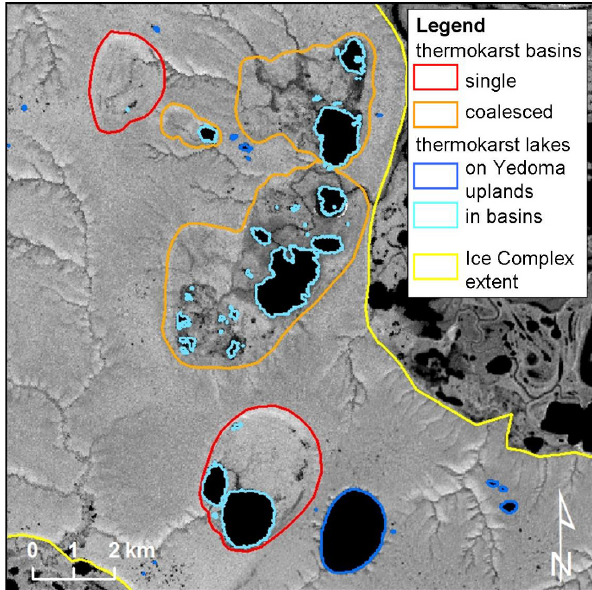
Fig. 3. Types of thermokarst features distinguished in this